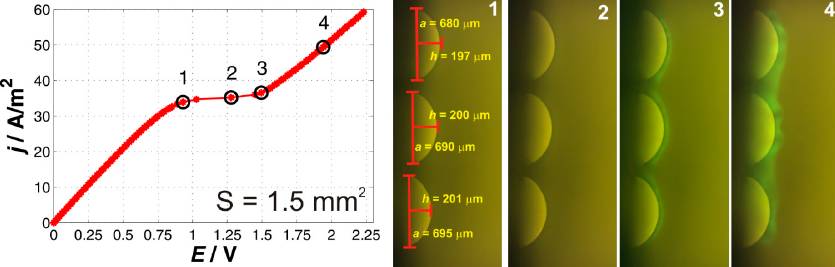
Figure 3. Current–voltage curve and a set of characteristic images for the three-particle membrane. The black circles on the current–voltage curve mark the current densities at which the depicted fluorescent images denoted as 1, 2, 3, and 4 were obtained.